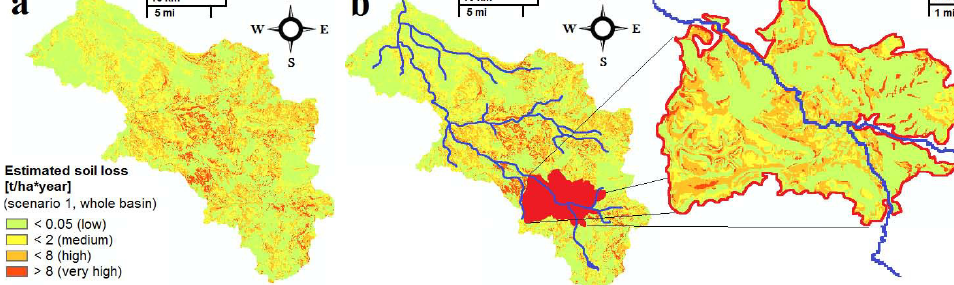
Fig. 4. Simulated soil losses under natural conditions (Scenario